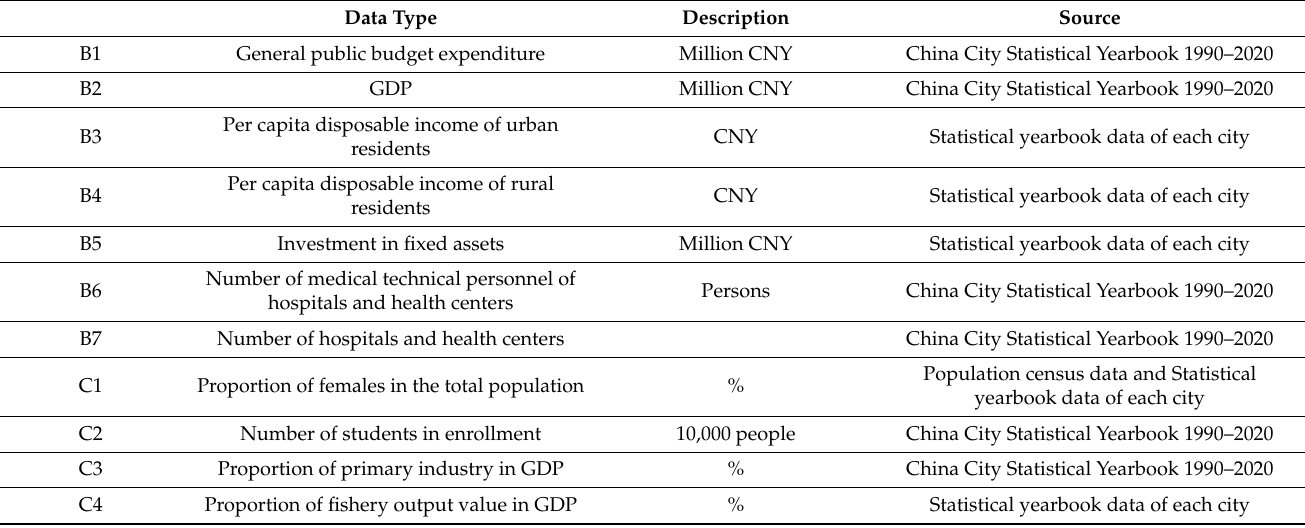
Table 1. Data sources for adaptive and sensitivity indicators.